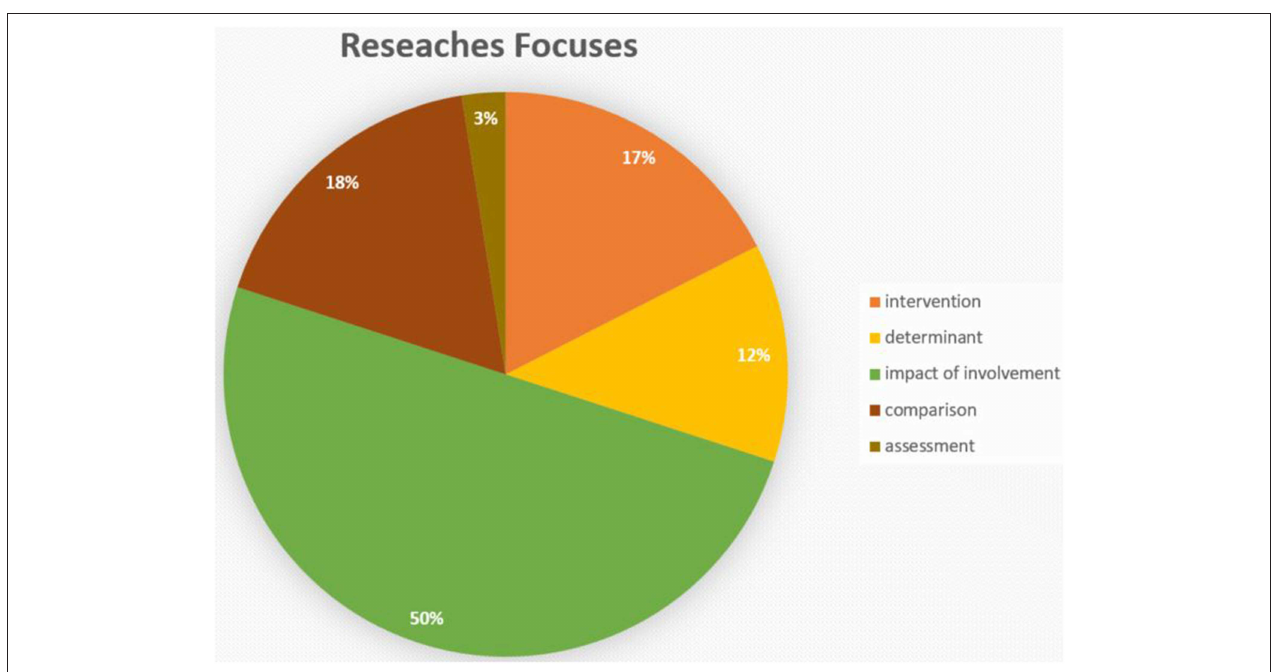
FIGURE 3 | Main researches